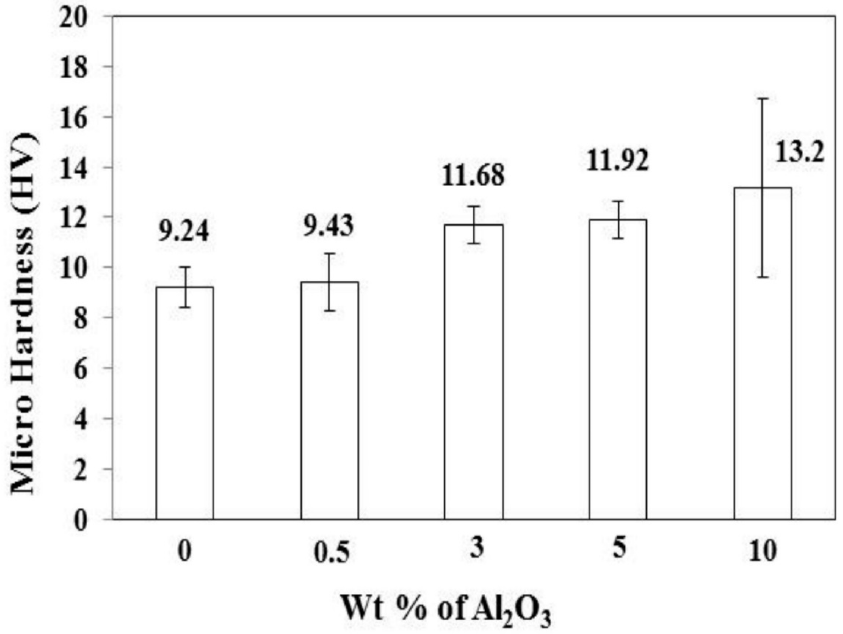
Figure 14. Microhardness of nanocomposite coatings (UHMWPE) with varying percentages of Al 2 O 3